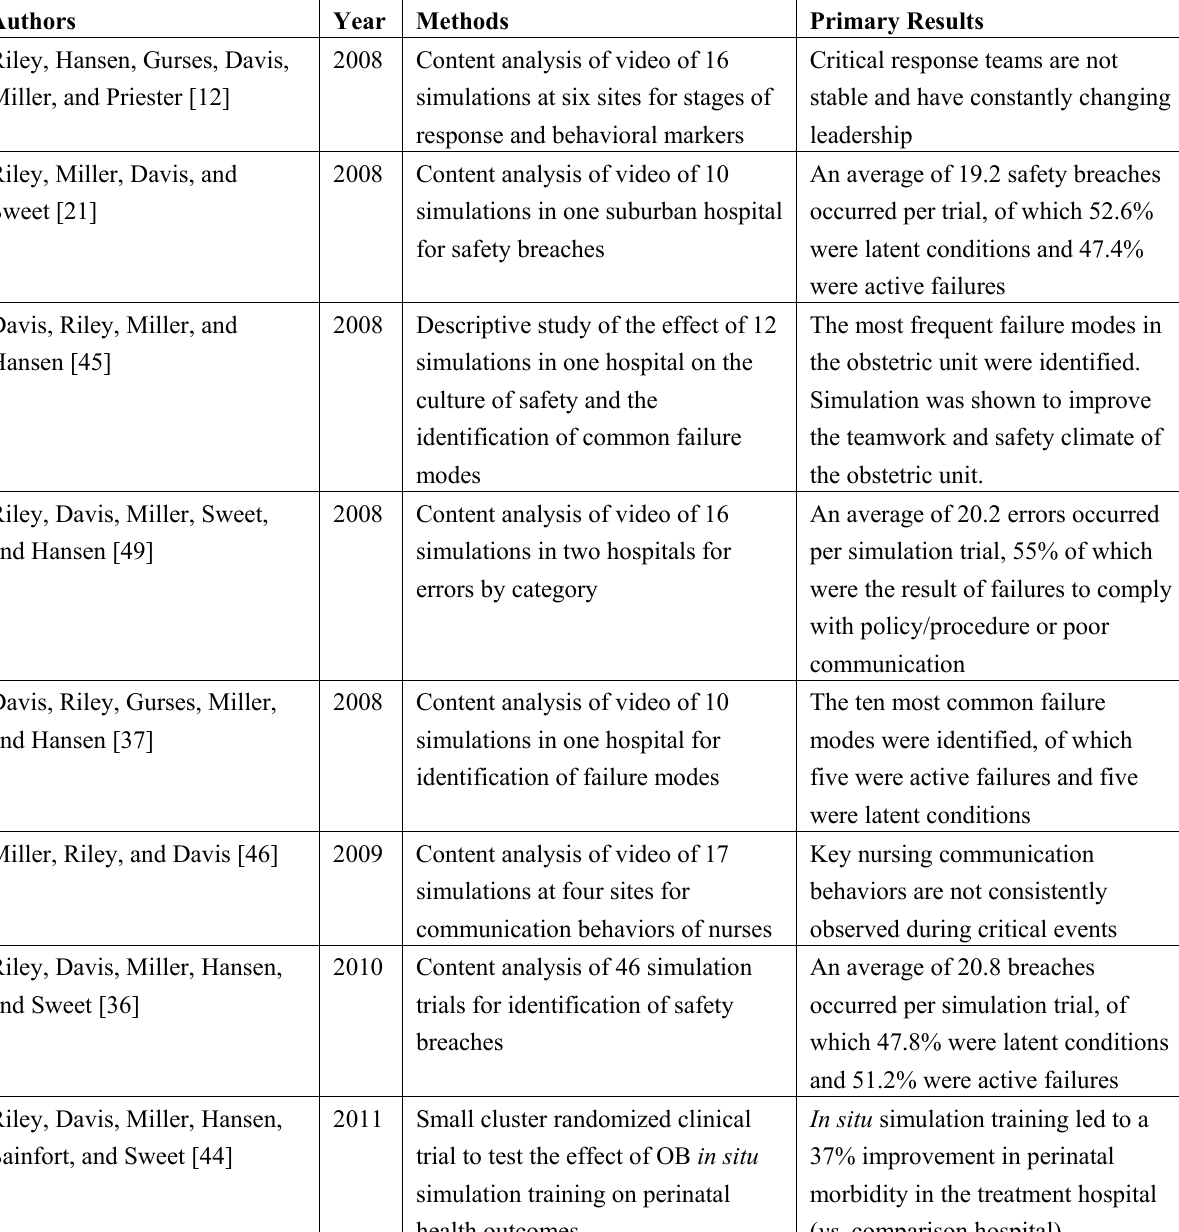
Table 6. Series of in situ simulation studies in obstetric